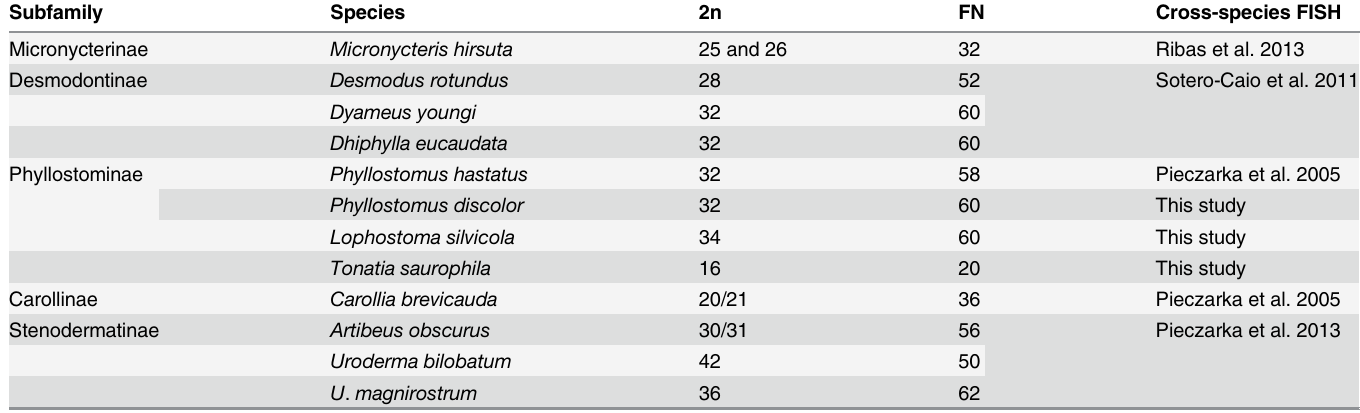
Table 1. Phyllostomidae species compared by chromosome painting in this